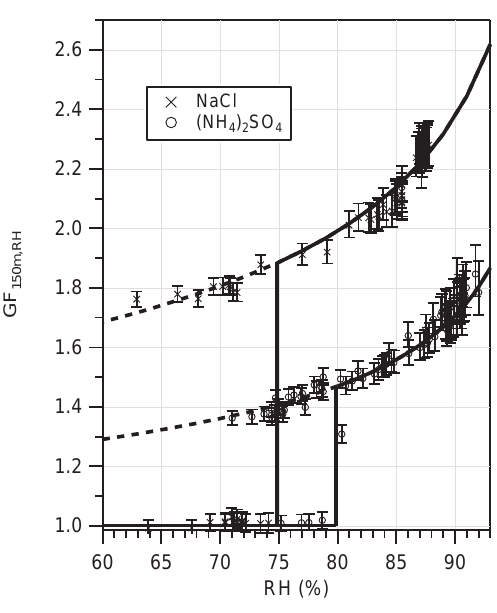
Fig. 3. HTDMA ammonium sulphate and sodium chloride calibra- tions made during the MAP